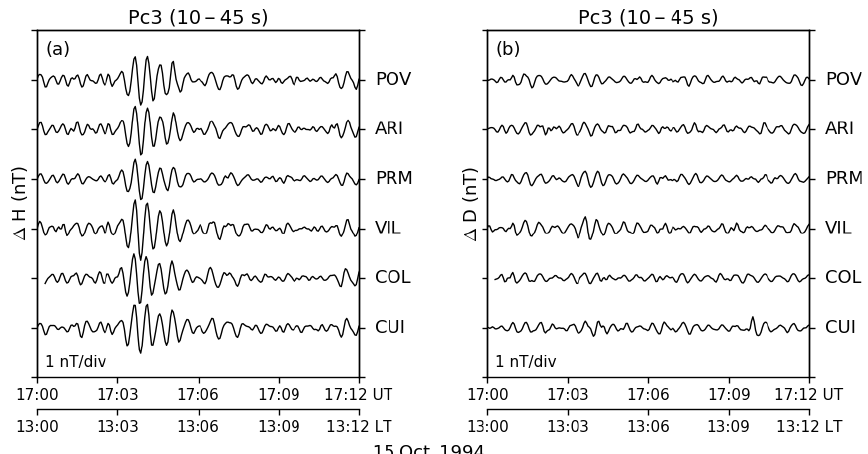
Figure 3. Band-pass-filtered geomagnetic variations ( H and D components) in the Pc3 interval (10–45s), shortly after noon on 15 Octo- ber 1994. A Pc3 event starting at ∼ 13:03LT is